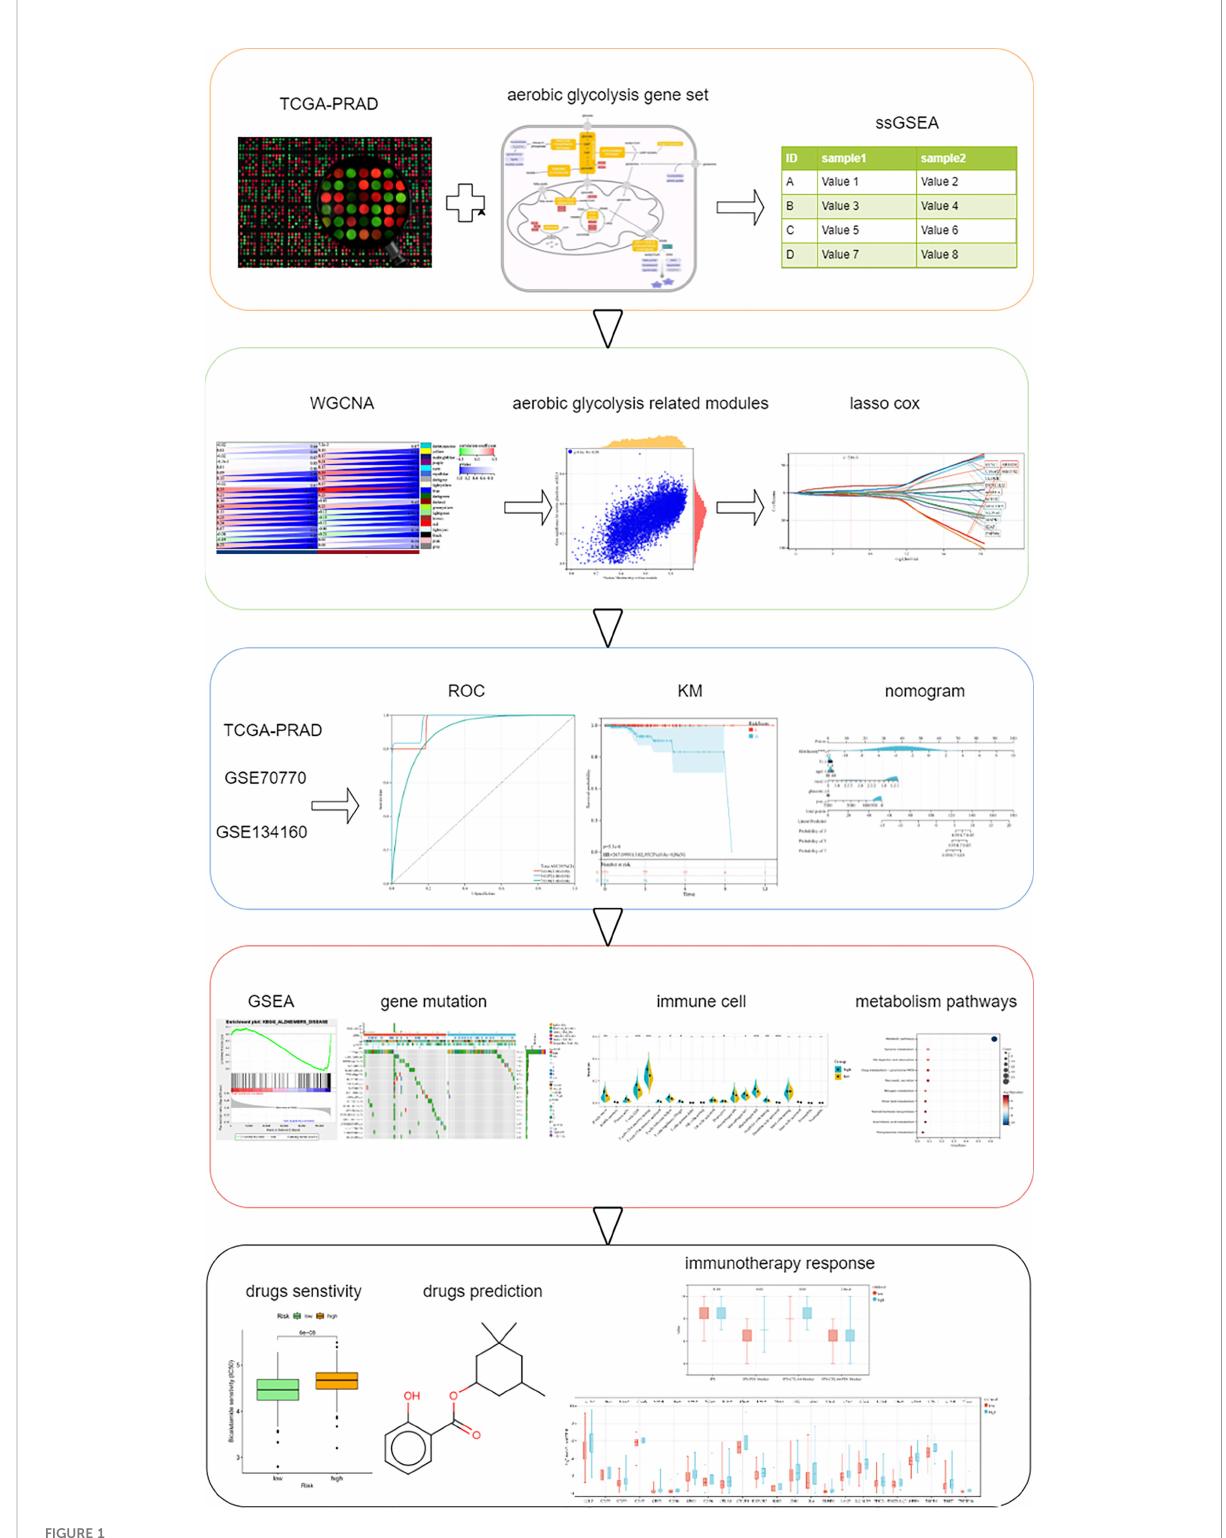
FIGURE 1 Schematic diagram of the study